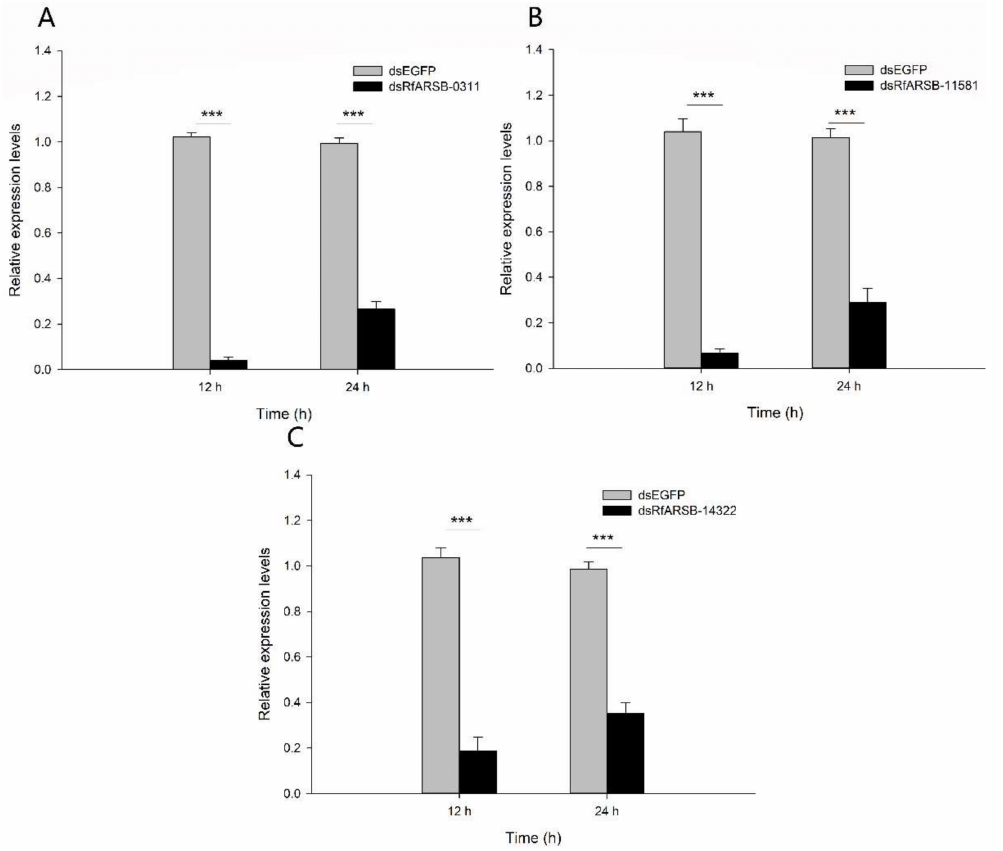
Figure 6. Determination of larval RNAi e ffi ciency of ( A ) RfARSB-0311 , ( B ) RfARSB-11581 , and ( C ) RfARSB-14322 detected at 12 h and 24 h after dsRNA injection. Expression levels were normalized to the GAPDH reference gene and the dsEGFP group. Data are shown as the mean ± SE from five independent biological repetitions. The asterisks marking the Student’s t test results indicate that there is a significant di ff erence between the dsEGFP and dsRfARSBs treatments (***, p <